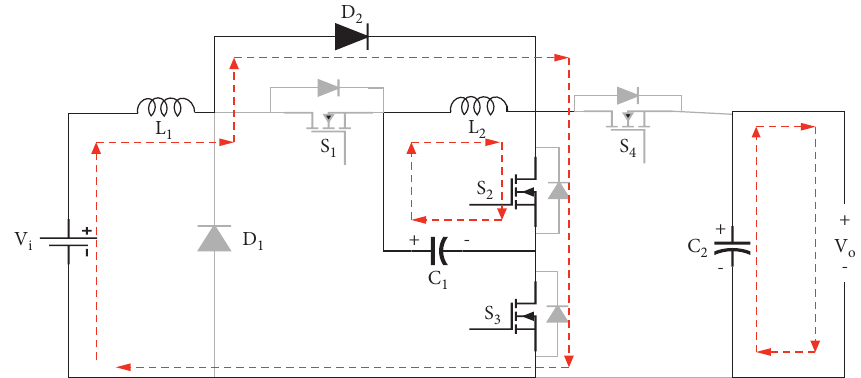
Figure 3: Converters’ boost mode operation in mode